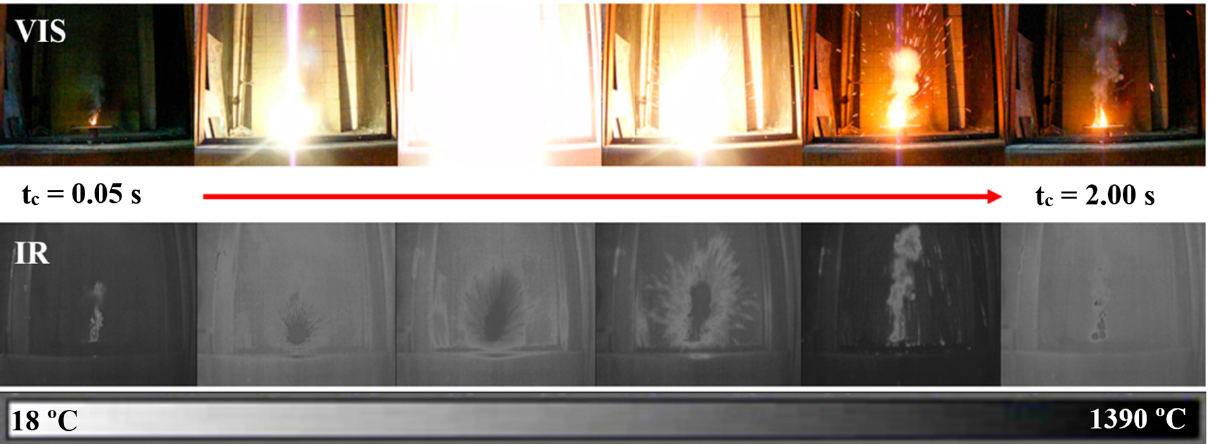
Table 3. Smoke chamber test results.